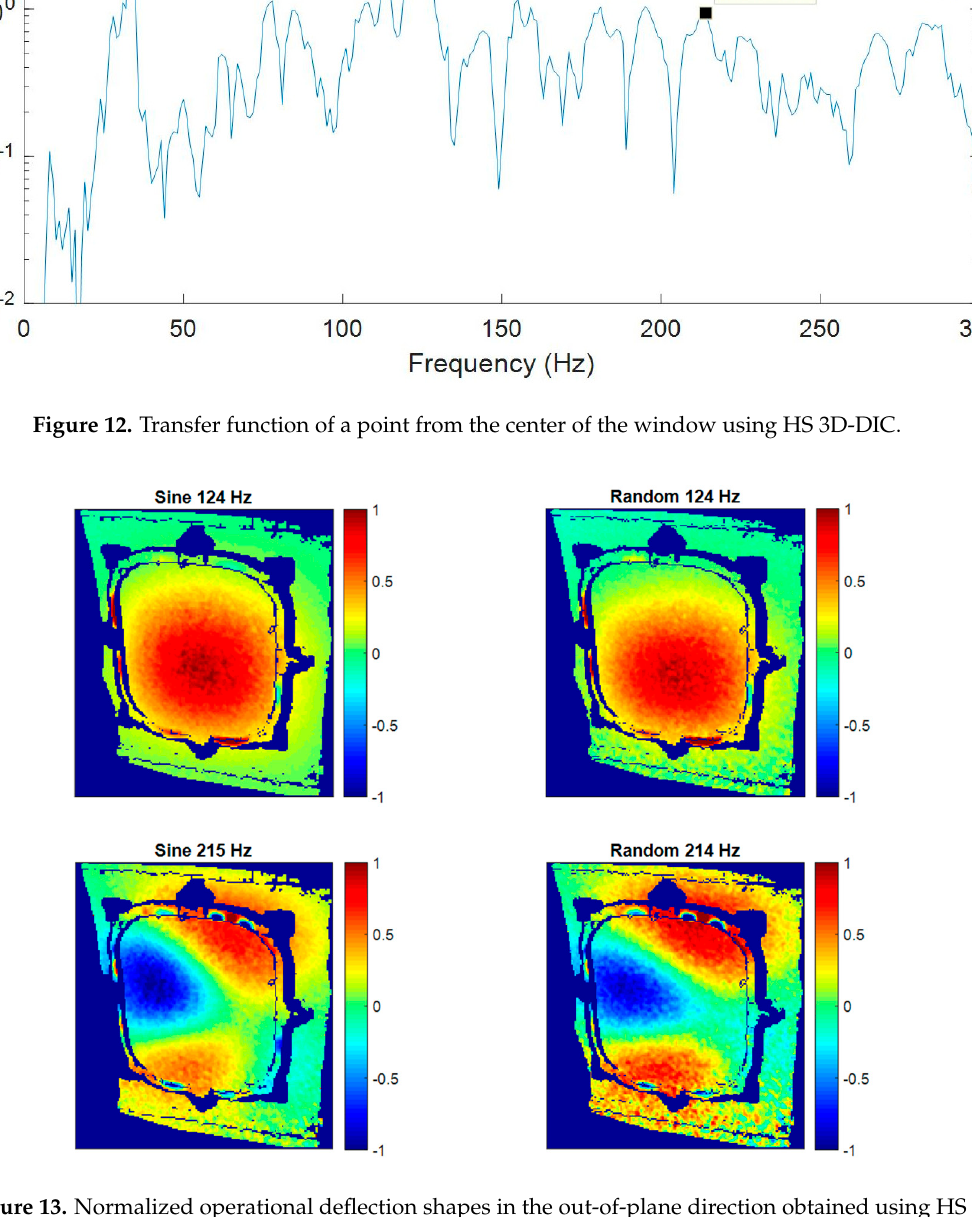
Figure 14. Additional normalized ODSs in the out-of-plane direction detected using HS 3D-DIC and random excitation. 4.1. Specimen 1 under Differential Pressure Differential pressure entails a homogenous force over the structure. In the passenger window area, the deformation due to differential pressure was measured by comparing the static state, shown in Figure 15. Maximum deformation occurs at the center of the window where the stiffness is lower.